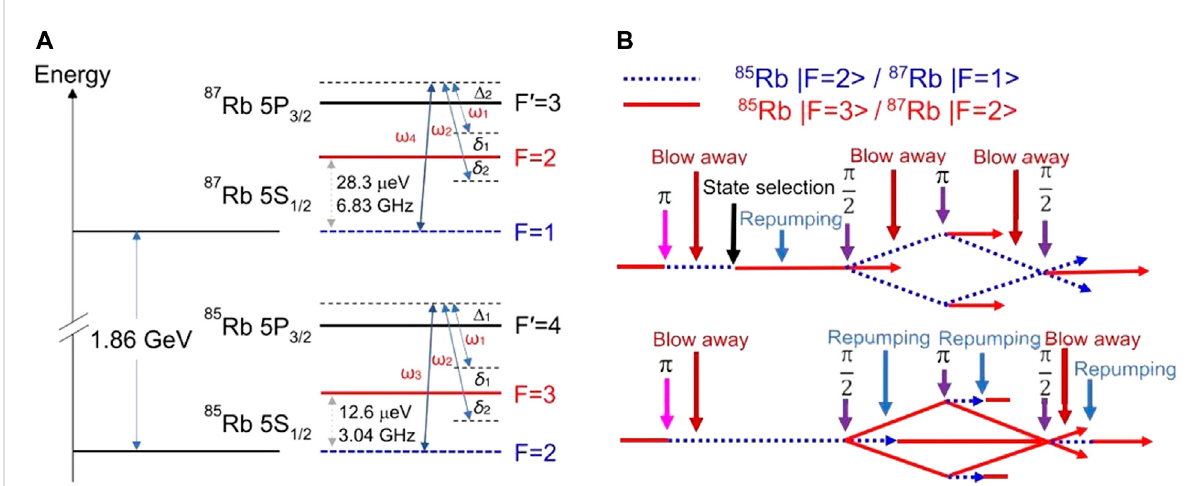
FIGURE 1 Schemeof4WDR-eforthedual-species atominterferometer of 85 Rb − 87 Rb. (A) Energylevel ofthetwospecies. Thelaserfrequenciesof ω 1 , ω 2 and ω 3 are used for 85 Rb atoms, while ω 1 , ω 2 and ω 4 for 87 Rb atoms. (B) Scheme of 4WDR-e. The blue dashed line represents lower ground state atoms, and thered solidline represents upperenergyground state atoms. The atominterferometer inthe4WDR-escheme worksinboth lower and upper ground states, while in the 4WDR scheme, it works only in the lower ground state (the upper one in